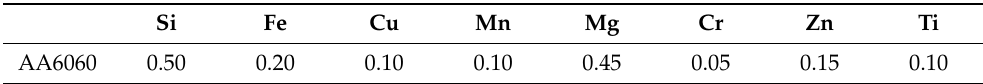
Table 1. Composition of AA6060 alloy employed